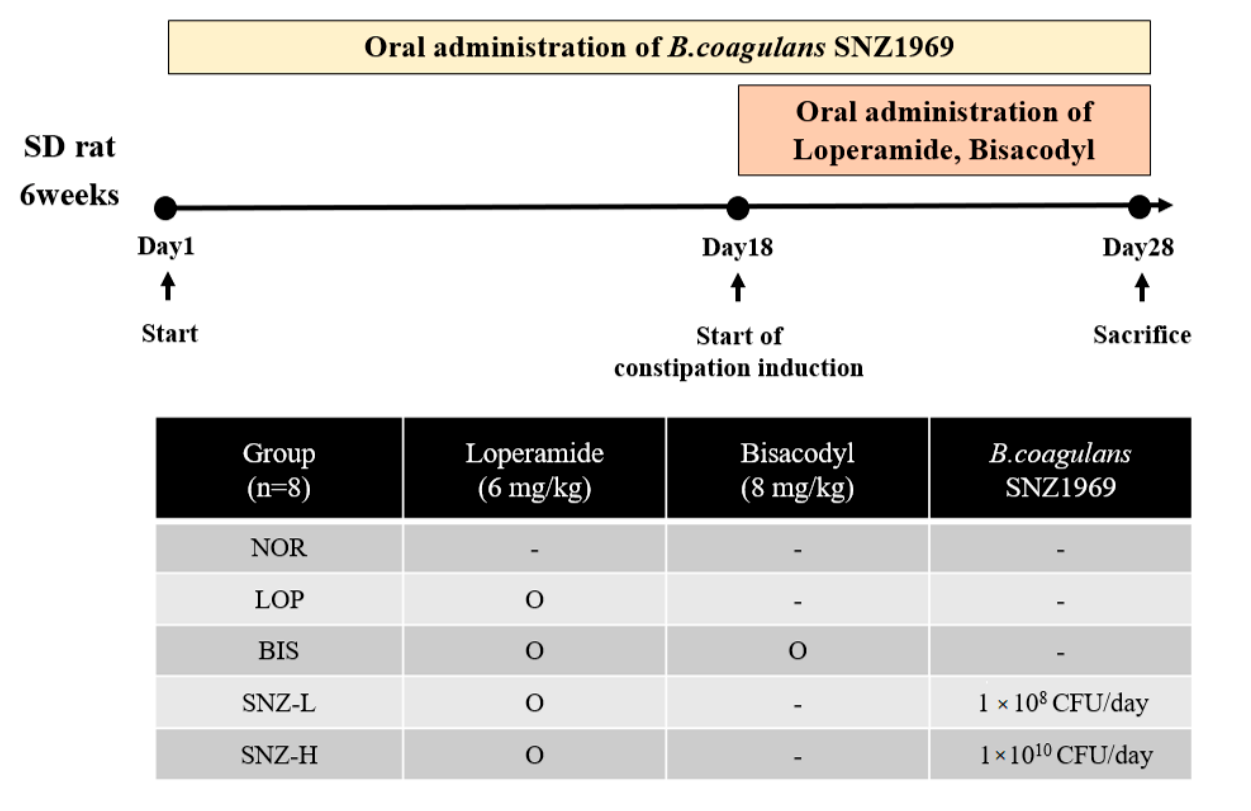
Figure 1. Experimental design. Experimental animals were five-week-old male SD rats. NOR: Normal group; LOP: Loperamide treated group; BIS: Loperamide and Bisacodyl 8 mg/kg treated group; SNZ-L: Loperamide and B. coagulans SNZ 1969 at 1 × 10 8 CFU/day treated group; SNZ-H: Loperamide and B. coagulans SNZ 1969 at 1 × 10 10 CFU/day treated